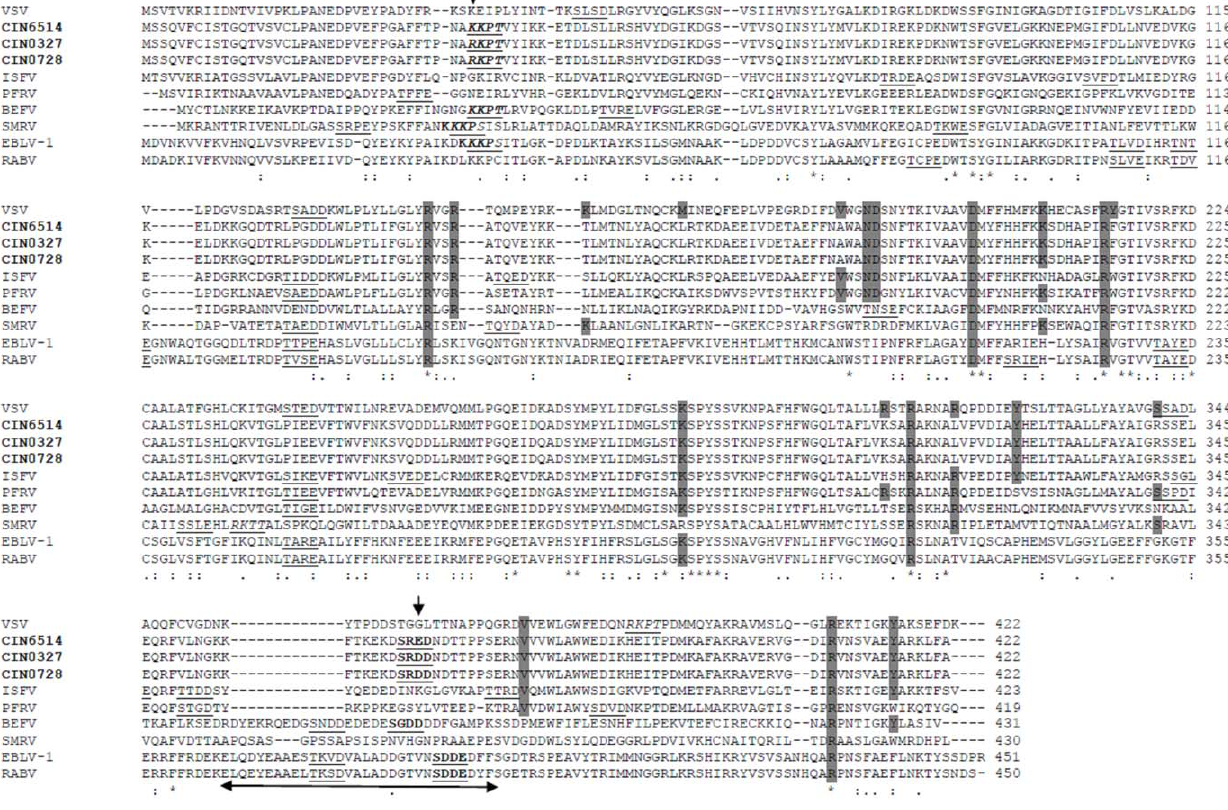
Figure 2. Profile alignment of N protein of representative CHPV isolates (shown in bold) with other representative rhabdoviruses. Residues known to be critical for VSV N protein function are highlighted in grey to indicate conservation. Putative CK II phosphorylation sites are underlined while putative CAMP phosphorylation sites are italicized and underlined. The two-headed arrow delineates the T cell epitope of lyssaviruses. Mutations in CHPV isolates are indicated by downward arrows.